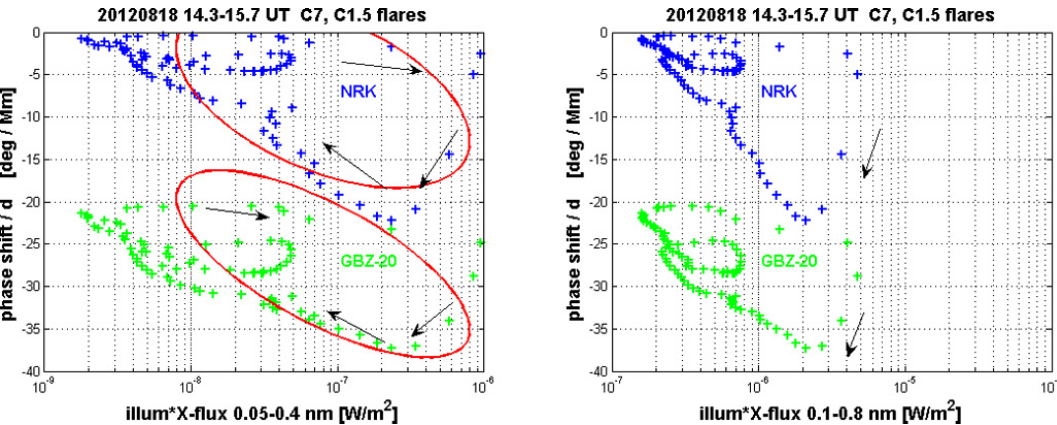
Fig. 10. Hysteresis loops of phase shift per Mm vs. cos(zenith angle) corrected lg(X-flux) (0.05–0.4nm left panel, 0.1–0.8nm, right panel) during 2 C-flares 20120818, cp. Figs. 7, 8. The arrows indicate the time development, the crosses are 1min apart. The GBZ data are shifted by − 20 degrees for better visibility. For the ellipses (left panel) see Sect.